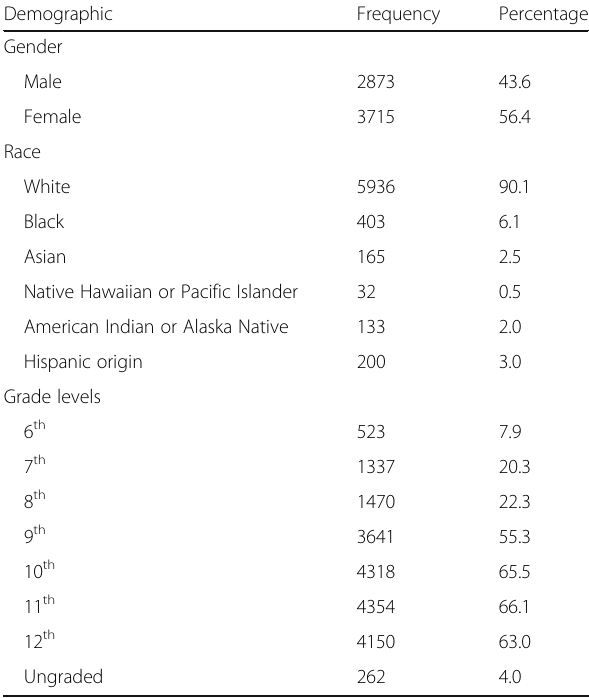
Table 1 Demographic characteristics of the